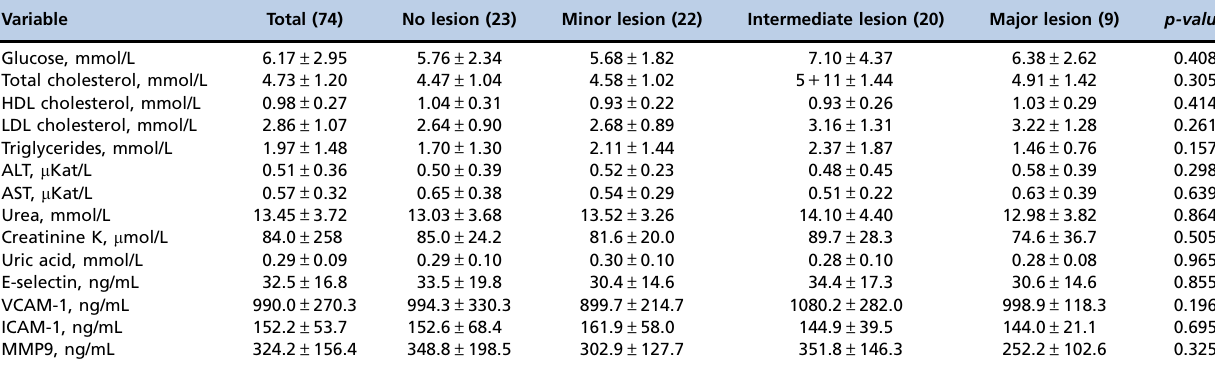
were considered statistically significant. Table 2 - Biochemical data according to the extent of the coronary lesion.